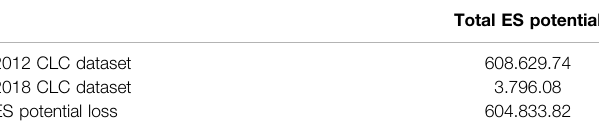
TABLE 1 | ES potential changes in 2012 – 2018 due to NMM and Istanbul Airport